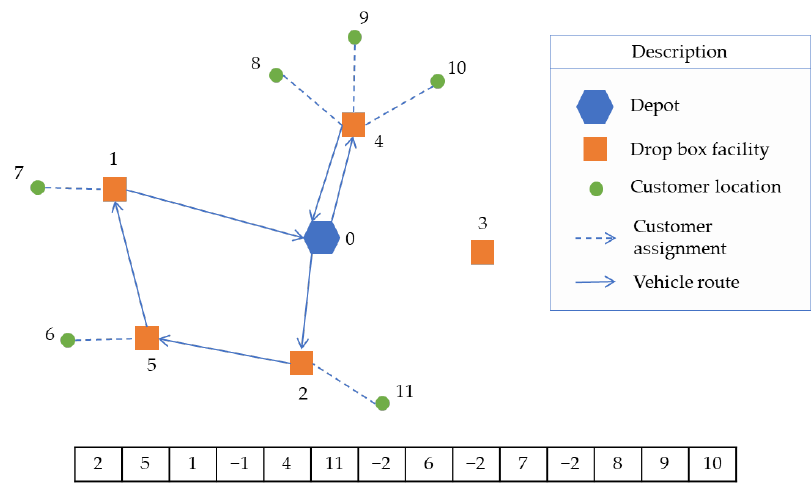
Figure 3. An example of solution representation for 2EVRP-DF. Table 1. Example of location, capacity, and demand for 2EVRP-DF.